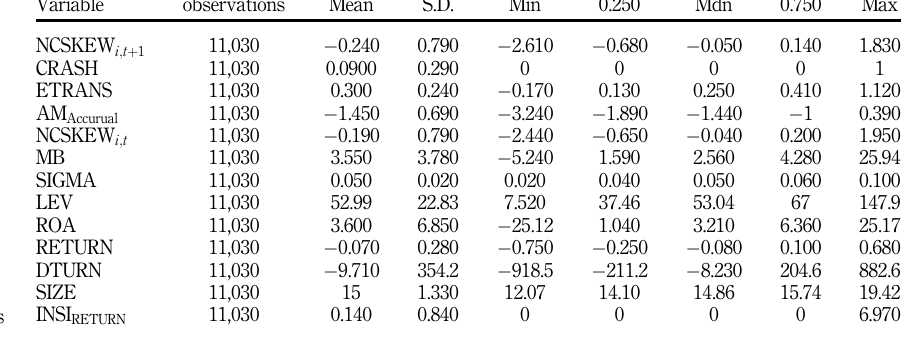
Table 1. Descriptive statistics